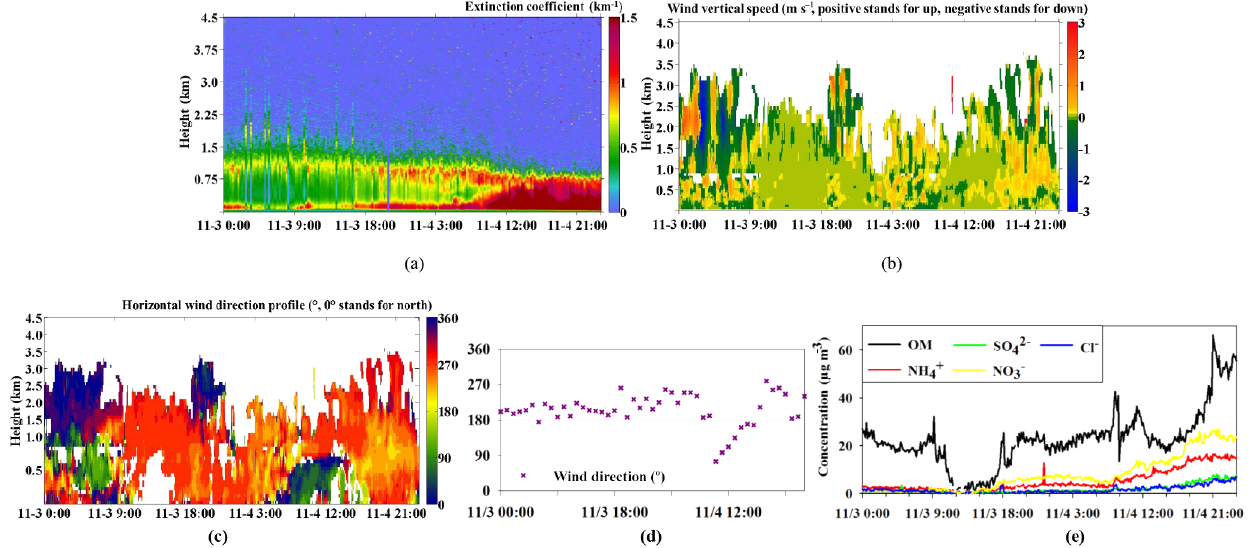
Figure 8. Characteristics of particulate matters and meteorological parameters during episode 2. (a) Vertical profile of extinction coefficient, (b) vertical profile of wind vertical direction and speed, (c) horizontal wind direction profile, (d) wind direction on the ground, (e) NR-PM 1 chemical components.